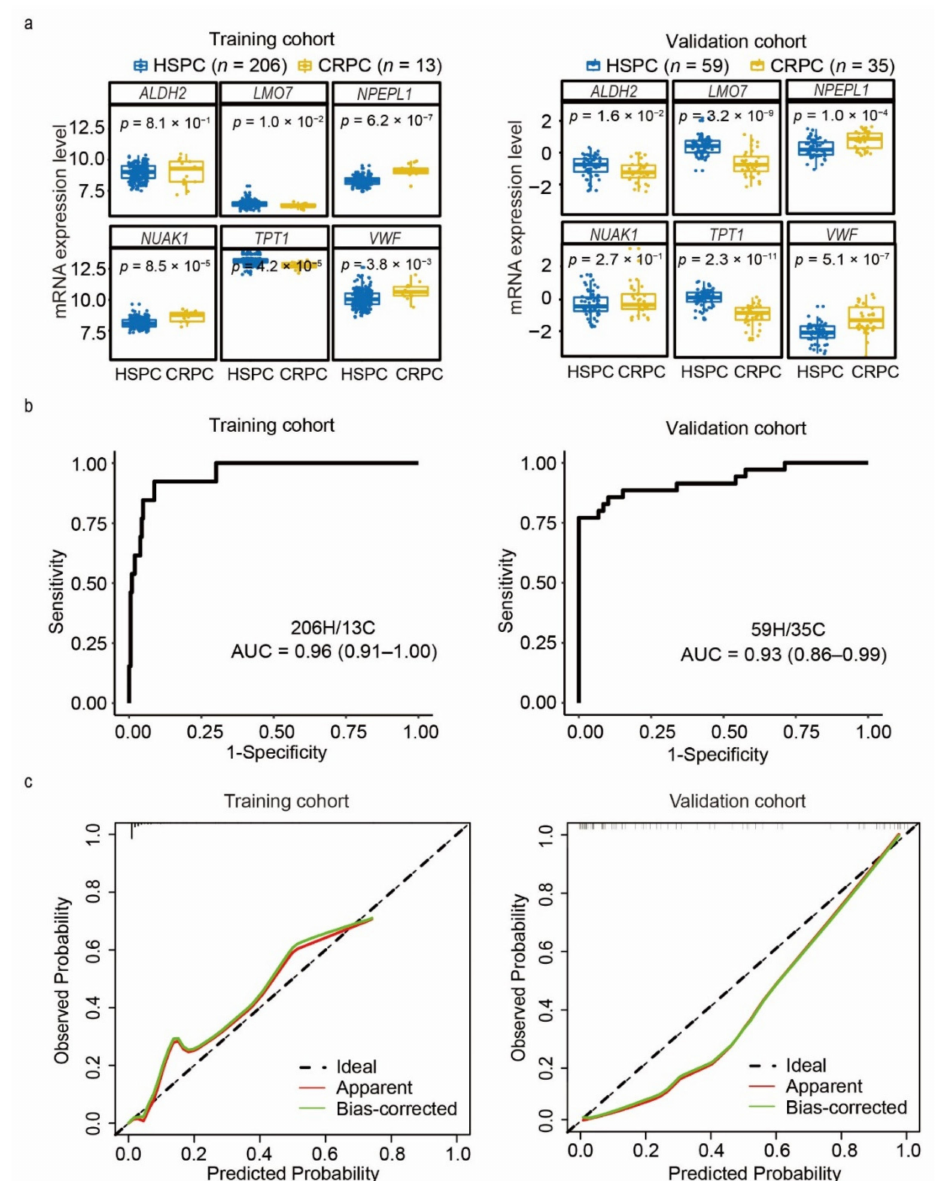
Figure 5. Three-gene panel derived from the six CRPCPS genes for prediction of CRPC occurrence. ( a ) Box plots of the six CRPCPS genes’ expression value in the training cohort (left panel) and validation cohort (right panel). ROC curves ( b ) and calibration plots ( c ) of the 3-gene CRPC diagnostic model in the training cohort (left panel) and validation cohort (right panel). H: HSPC, C: CRPC. The diagonal dotted line represents a perfect prediction by an ideal